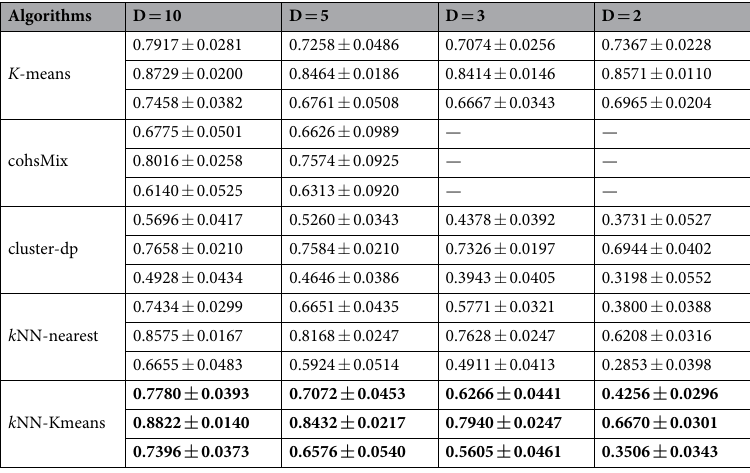
Table 6. Results on LFR networks with numerical attributes, μ =